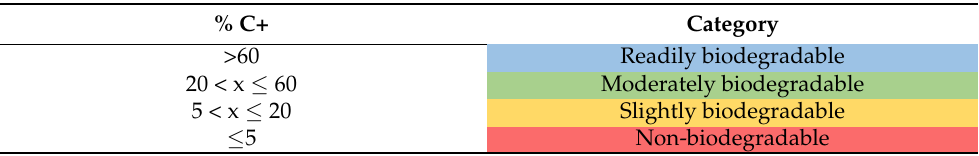
Table 1. Proposed assessment criteria for the classification (four-colored) of marine biodegradability of plastic materials according to the % of BOD 28 obtained for a positive control (C+) consisting of the fully biodegradable polymer